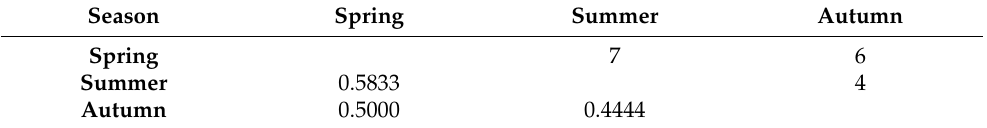
Table 2. Bird community similarity coefficient and number of common species in each season. Season Spring Summer